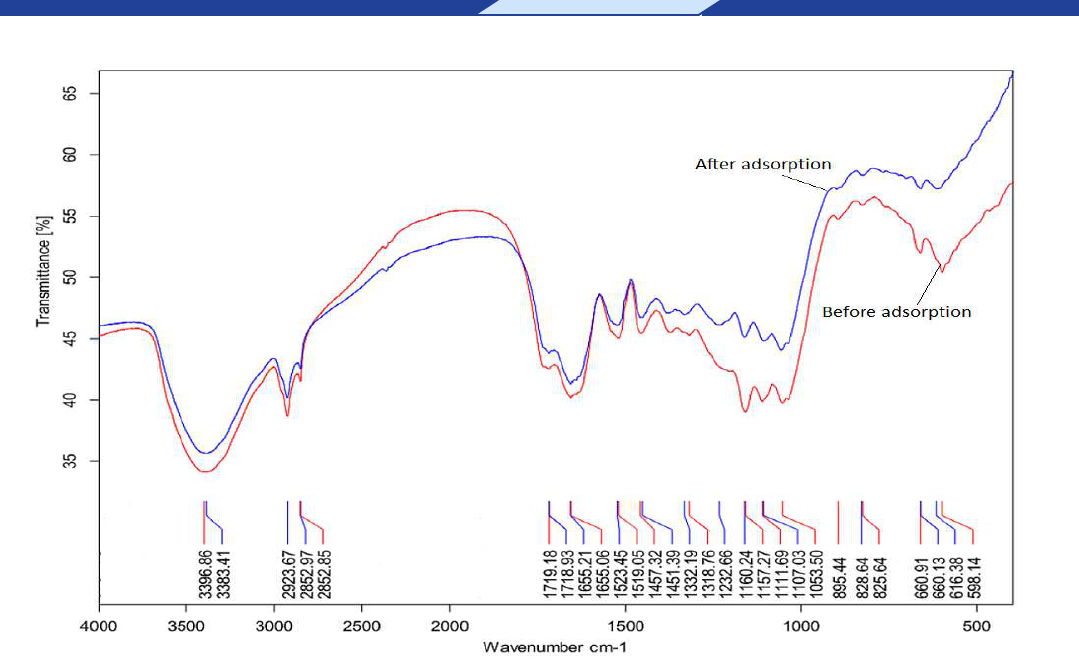
Figure 3. Fourier transform infrared spectroscopy (FTIR) spectra of acid-activated spent tea (AAST) before and after adsorption of methylene blue (MB) Table 3. Fourier transform infrared spectroscopy (FTIR) spectra of acid-activated spent tea (AAST) before and after adsorption of methylene blue (MB) Frequencies (cm -1 ) FTIR peaks Assignment Before adsorption After adsorption